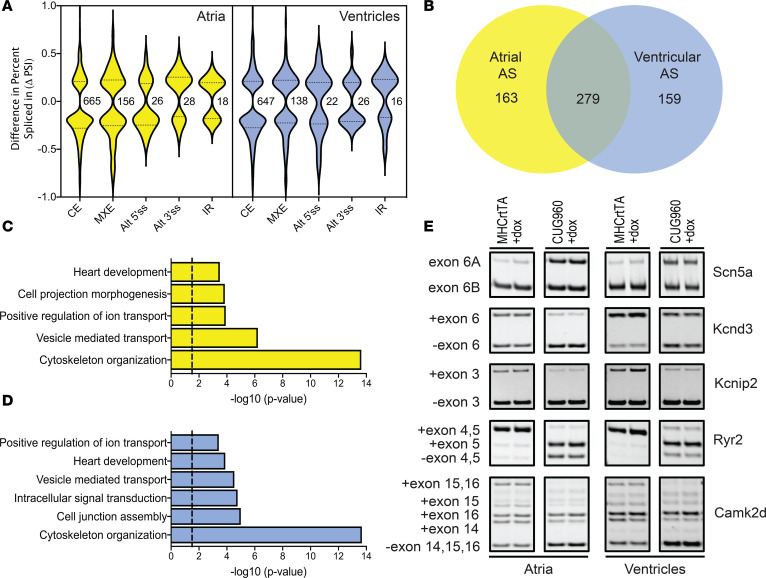
CUGexp RNA induced alternative splicing changes in atria and ventricles.(A) Violin plots depicting the distribution of splicing events based on ΔPSI and types of AS changes observed in atria and ventricles of CUG960 +dox mice. (B) Overlap observed between genes showing alternative splicing changes in atria and ventricles of CUG960 +dox mice. Genes showing differential alternative splicing changes in (C) atria and (D) ventricles in CUG960 +dox mice were evaluated for enrichment of gene ontology functional terms using DAVID platform. Cutoff > –log (P value) = 1.5. (E) Representative RT-PCRs showing alternative splicing changes for candidate ion transport genes, Scn5a, Kcnd3, Kcnip2, Ryr2, and Camk2d, in atria and ventricles of CUG960 +dox mice in comparison with MHCrtTA +dox controls. n = 2 animals per group. CUGexp, expanded CUG repeat; dox, doxycycline; CE, cassette exons; MXE, mutually exclusive exons; Alt 5′ss/Alt 3′ss, alternative 5′/alternative 3’ splice site; IR, intron retention.